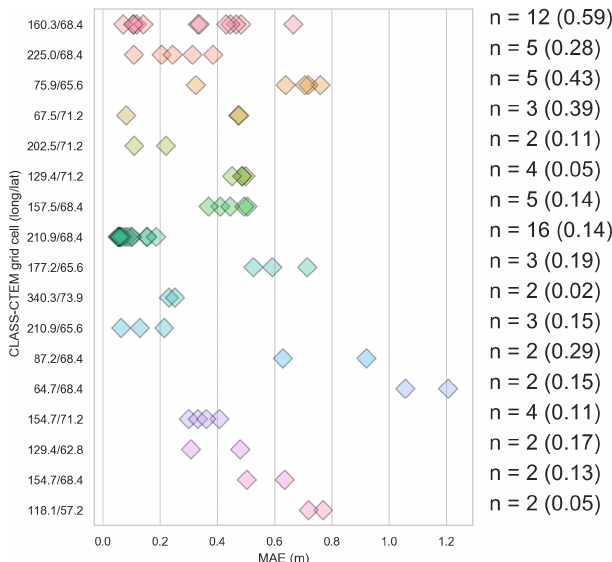
Figure 8. MAE for CLASS-CTEM grid cells with multiple GTN- P ALT sites for the SoilGrids+Moss simulation. The number of ALT sites is listed along with the range in MAE in each grid cell in